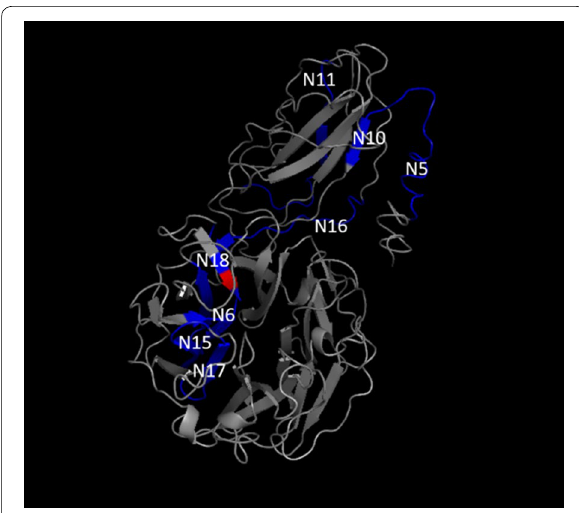
Fig. 4 Neuraminidase peptides. N5, N6, N10, N11, N15, N16, N17 and N18 are schematically presented in blue in the protein structure after its modeling. N18 includes the catalytic site presented in red. Brazil,